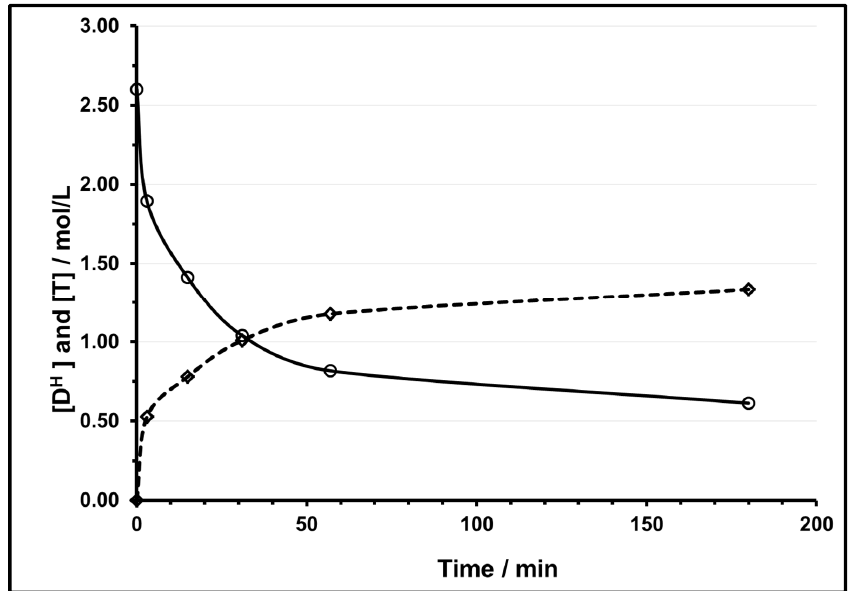
Figure 5. HMeSiO 2/2 (D H ) unit conversion vs. time (-) and chain branching units (MeSiO 3/2 ) (T) formation vs. time (---) dependences in the restructuration of 20 wt% PHMS solution in toluene in the presence of 7.6 × 10 − 3 mol/L of B(C 6 F 5 ) 3 at 30 °C.